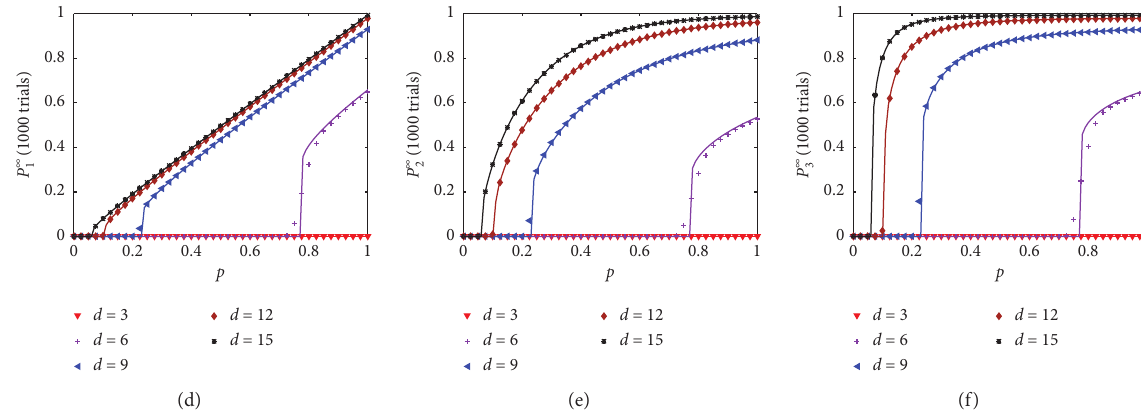
Figure 7: Robustness of tripartite networks based on the local model. Lines denote the theoretical results while symbols represent the simulation results. The first and second rows of the figure, respectively, represent the case that the node removal occurs to S i for all i ∈ [ 1 , 3 ] and for i � 1. Simulation results are averaged over 1000